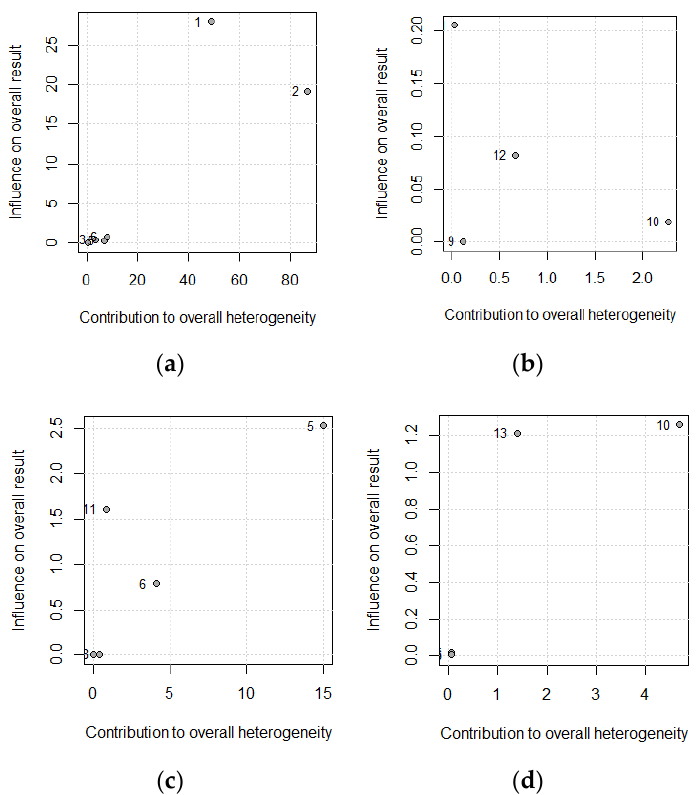
Figure 4. Baujat plot for ( a ) Crohn´s disease activity index, ( b ) fecal calprotectin, ( c ) C-reactive protein, and ( d ) albumin: the numbers in the plot correspond to the classification shown in Table 5.